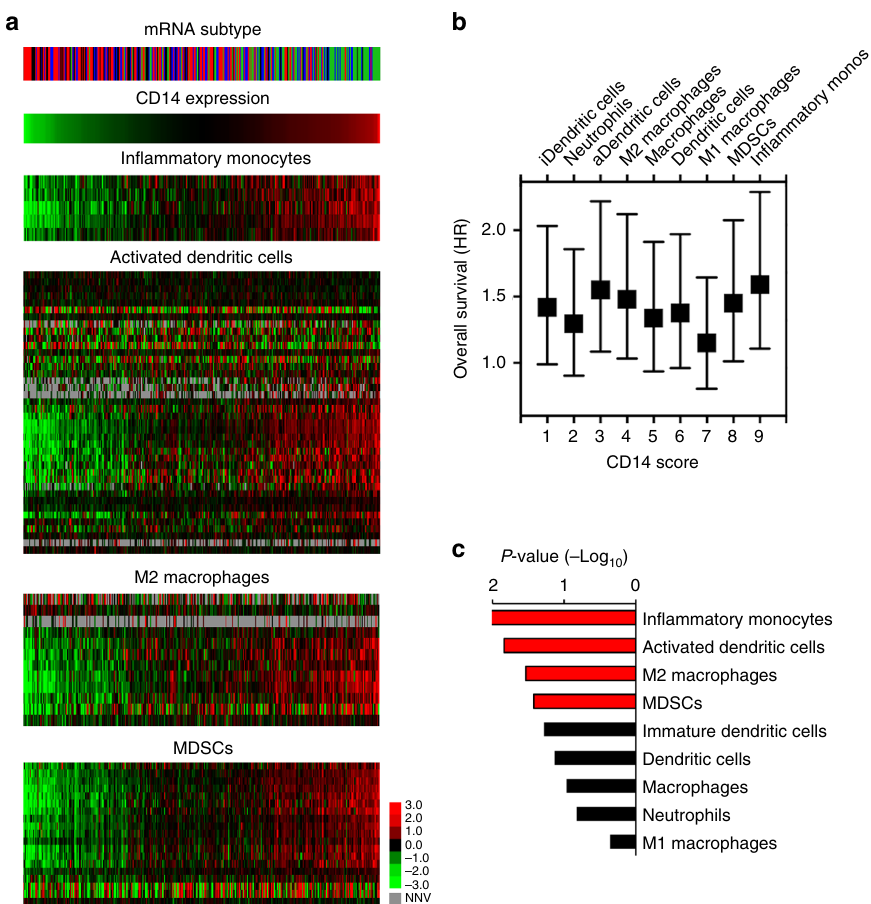
Fig. 3 IMs have the strongest correlation with CD14 and LUSC survival. a At top, the mRNA subtype of each sample is displayed (Classical: red, Basal: blue, Primitive: black, Secretory: green); CD14 expression levels sorting from left (lowest) to right (highest) for the corresponding samples are displayed below. Heat maps of the CD14 + populations that are associated with a statistically signi fi cant survival in LUSC are arranged by the most (IMs) to the least (MDSCs) statistically signi fi cant. CD14 is a marker both of IMs and MDSCs but is not shown in their heat maps, to avoid data redundancy. Note for the heat map fi gure legend: gray represents ‘ null normalized values ’ (NNV). b Scatter plot of overall survival results and CD14 scores for the 9 CD14 + immune cell types. Survival is represented with hazard ratio (HR) ± 95% con fi dence intervals. Values above 1 indicate worse survival based on cell type density. The CD14 score is the rank of the ratio between the average cell type density score of samples with high ( ≥ median) vs. low ( < median) CD14 levels. c Log-rank p -values of overall survival for the 9 CD14 + immune cell types (high vs. low cell density score). The red bars show statistically signi fi cant cases, while black bars are used when the statistical signi fi cance threshold of 0.05 is not